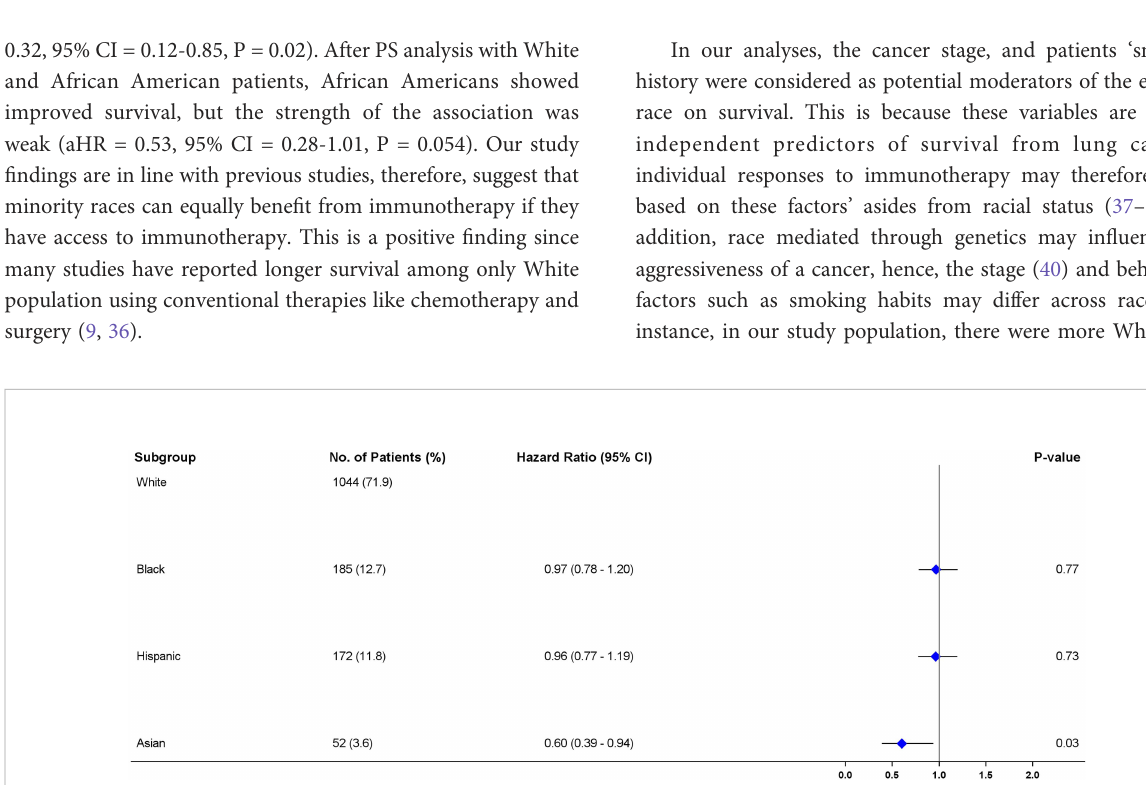
FIGURE 5 Forest plot of multivariable Cox proportional hazard regression analysis showing the association between patient characteristics and disease- speci fi c survival using the inverse probability treatment weighting (IPTW)